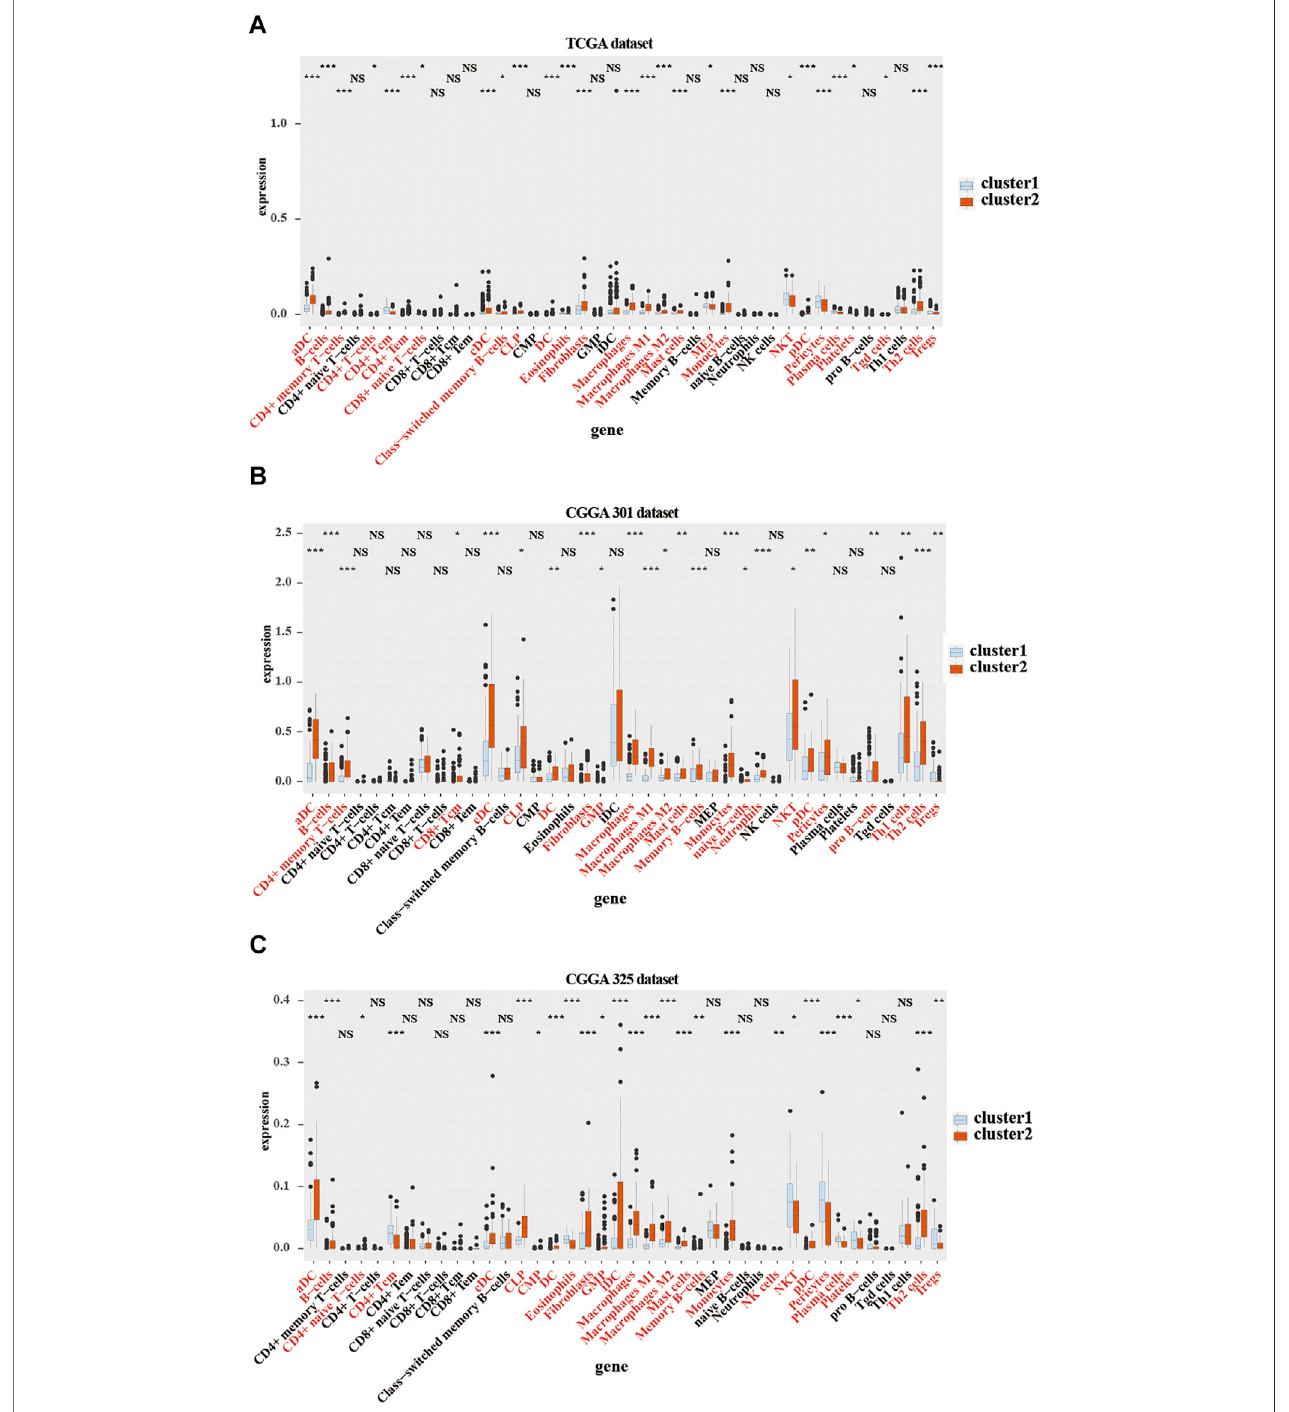
FIGURE 4 | Immune cells in fi ltration in cluster 1 and cluster 2 from TCGA and CGGA301 databases. xCELL algorithm of in fi ltrated immune cells in cluster 1 and cluster 2 from TCGA (A) , CGGA301 (B) , and CGGA301 (C) databases. The Wilcox test was used to compare the difference between the two groups (ns: no signi fi cant differences, * p < 0.05, ** p < 0.01, and *** p < 0.001).